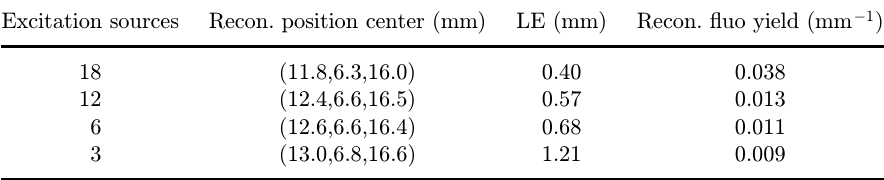
Table 6. Reconstruction results by CoSaMP with di®erent numbers of excitation sources.